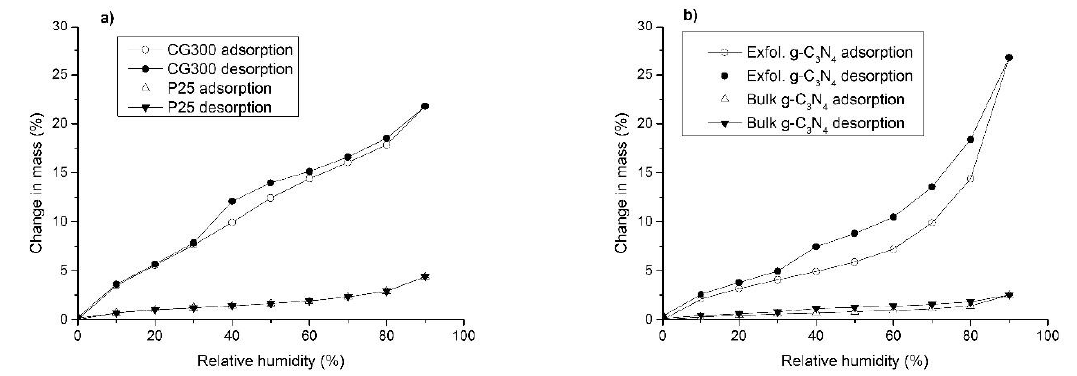
Figure 5. Moisture adsorption and desorption isotherm plots of TiO 2 ( a ) and g-C 3 N 4 ( b ).